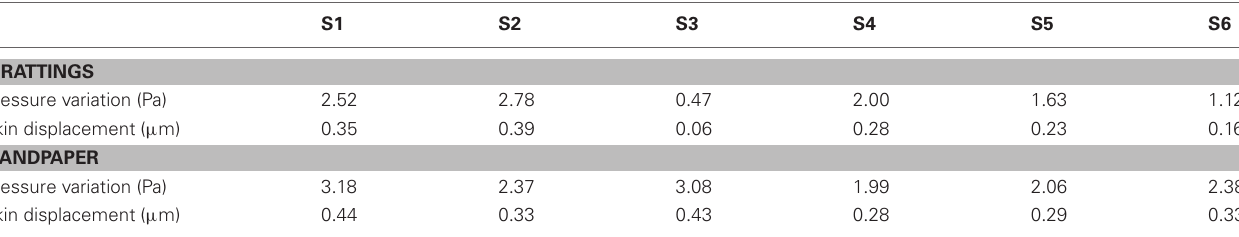
Table 5 | Normalization factors for pressure variation and skin displacement for each subject (corresponding to 0 in the log scale of Figure 7).